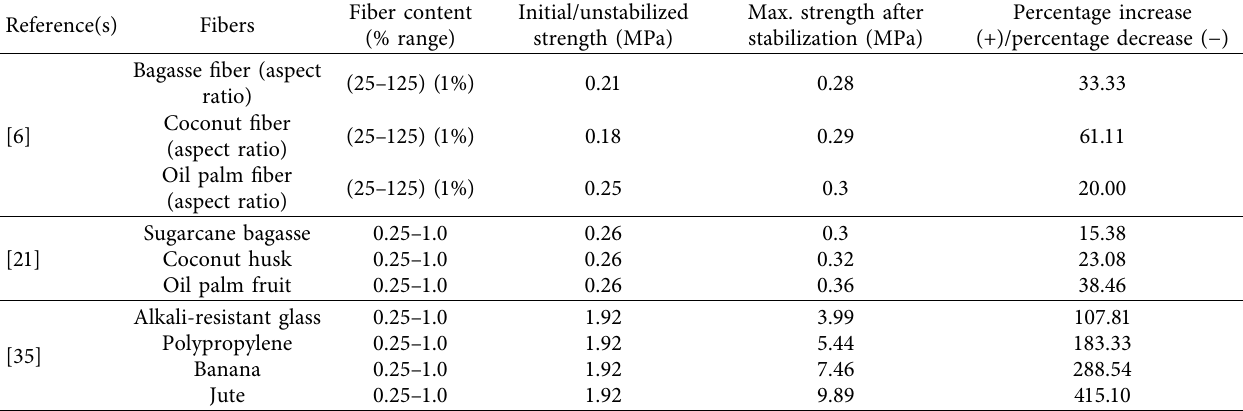
Table 12: Tensile strength of unfired admixed soil blocks as reported in the reviewed articles.